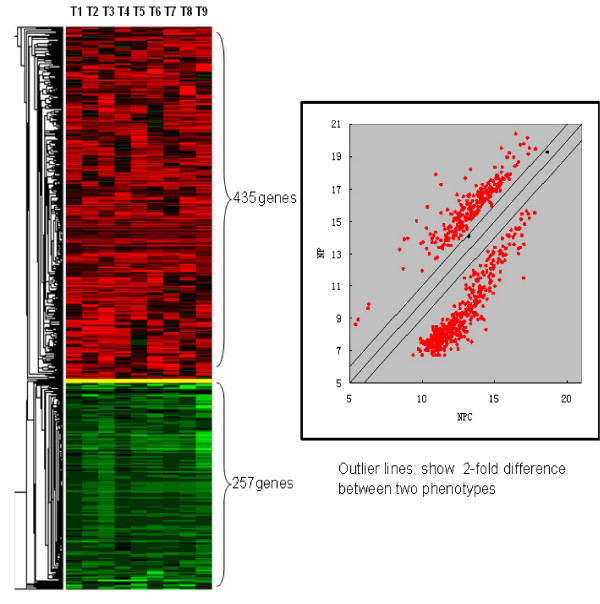
Class comparison and hierarchical clustering analysis. T1-T8: Pooled NPCs compared to pooled NPs; T9: Pooled NPC cells compared to pooled NPs; Green region: down-regulated genes, Red region: up-regulated genes.